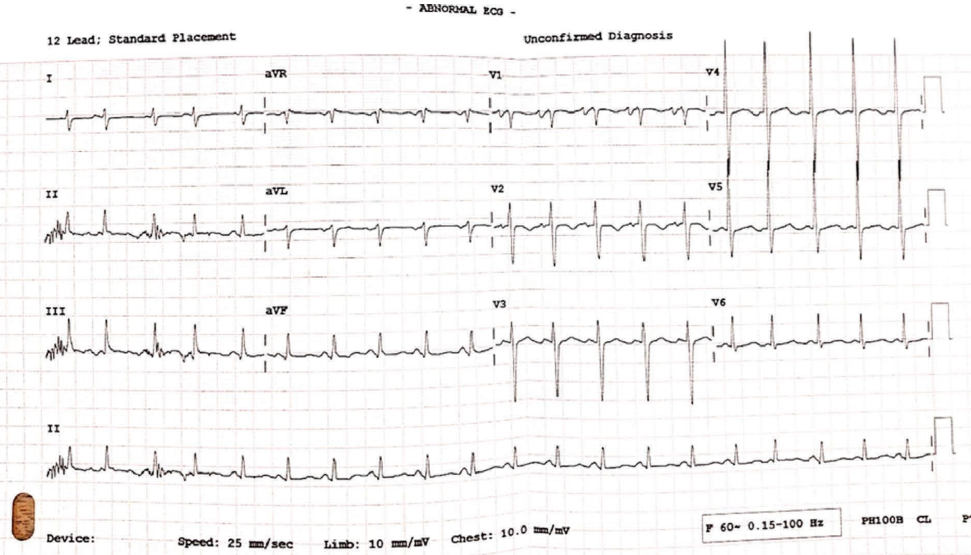
Figure 1: ECG at presentation showing sinus tachycardia and a right axis deviation. P wave duration of 120 ms with deep terminal portion > 1 mm (left atrial component) in V1 indicative of a dilated left atrium. Te dilated left atrium is a result of an increased volume load from the severe mitral